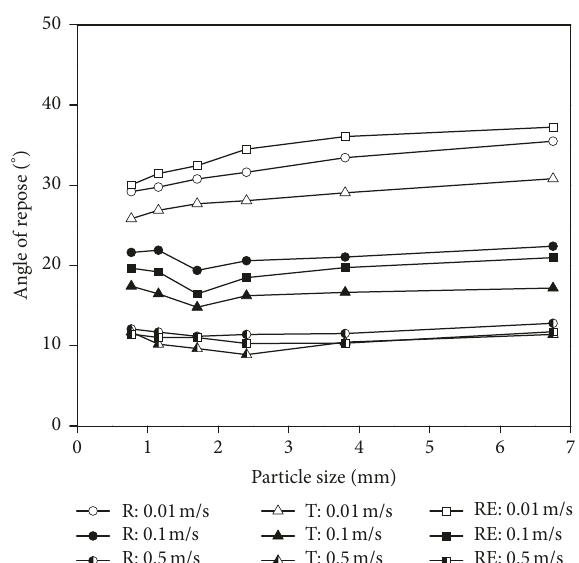
Figure 6: The impact of container shape on angle of repose.